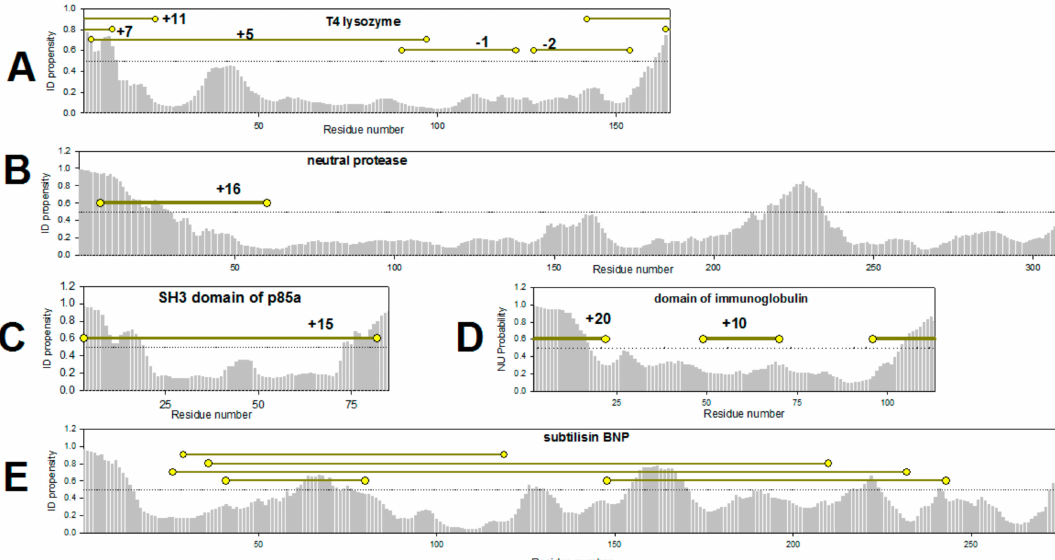
Figure 2. Intrinsic disorder propensity evaluated by PONDR ® FIT for the amino acid sequences of T4 lysozyme PDB:1SX7 ( A ), neutral protease PDB:1NPC ( B ), SH3 domain of p85a PDB:1PHT ( C ), immunoglobulin domain PDB:1HCV ( D ), subtilisin PDB:2ST1 ( E ). Yellow circles show the positions